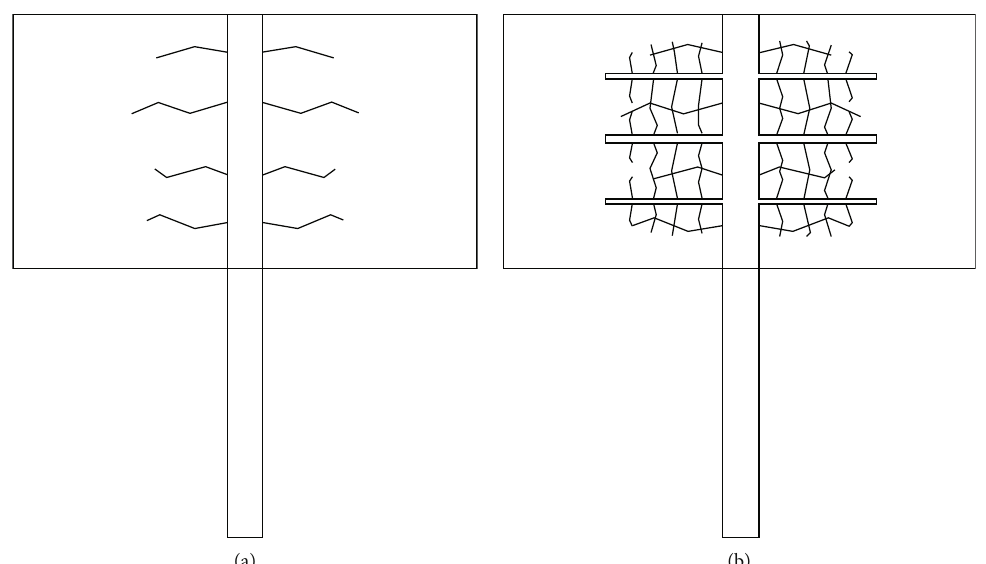
Figure 3: Fissure distribution. (a) Schematic diagram of the development of fi ssures around ordinary boreholes. (b) Schematic diagram of the development of fi ssures around the slotted hole.